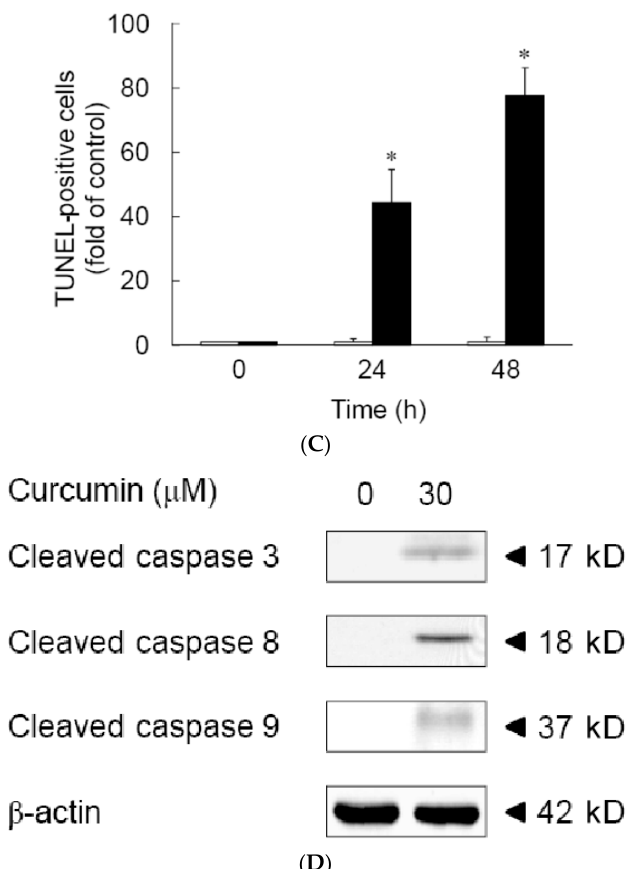
Figure 2. High-dose curcumin induces apoptosis in 3T3-L1 preadipocytes. ( A – C ) 3T3-L1 preadipocytes were left untreated ( ) or were incubated with 30 μ M curcumin ( ) for 24 ( B – C ) or 48 h ( B , C ), then cell apoptosis was examined by TUNEL staining (blue fluorescence DAPI staining of nuclei and green fluorescence TUNEL staining of apoptotic cells) (A) and quantified by flow cytometry (B,C). ( D ) Western blots of cleaved caspase 3, 8, and 9 in 3T3-L1 preadipocytes after 24-h incubation in medium alone or medium containing 30 μ M curcumin. In (A), (B), and (D), the results shown are representative of those in four separate experiments. In (C), the results are the mean ± SD for four independent experiments. * P < 0.05 compared to the vehicle control.